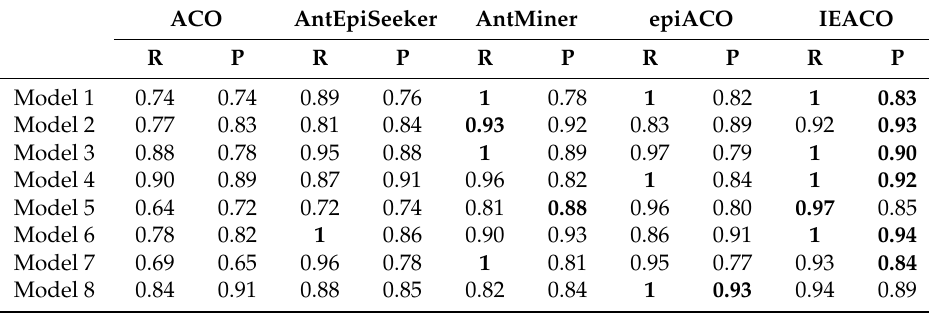
Table 3. Results of recall and precision on 500-SNP datasets.